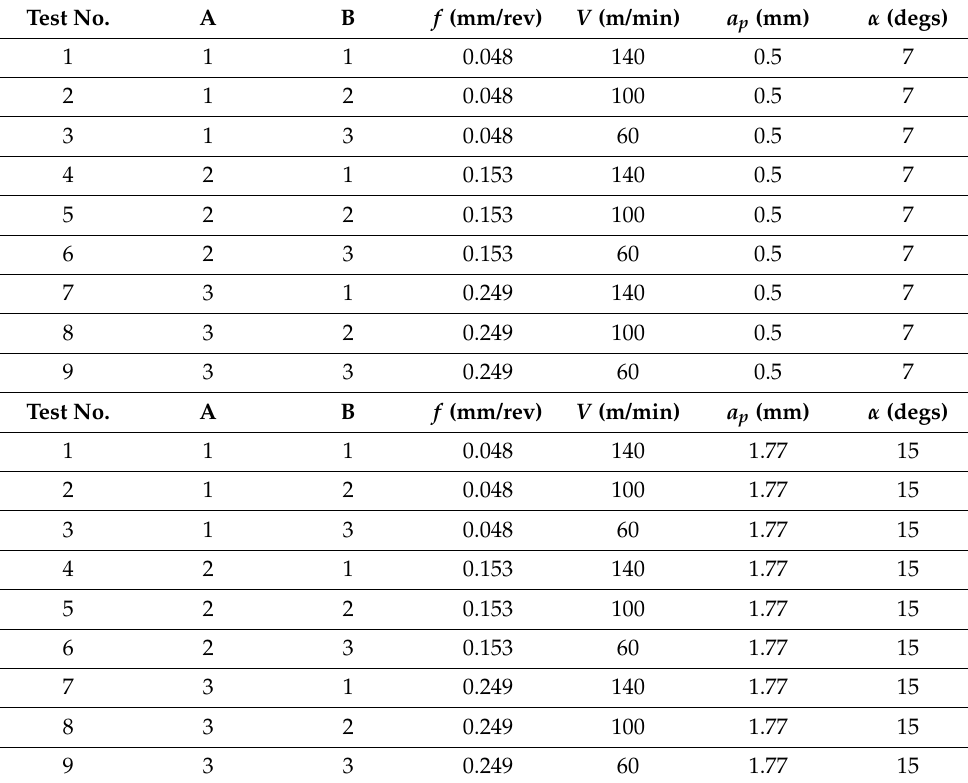
Table 4. Parameter values for individual tests